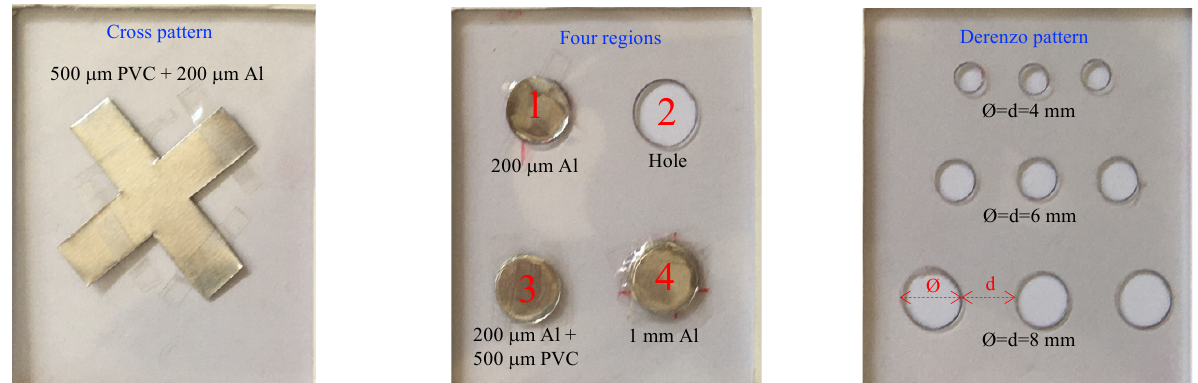
Fig. 4. Set of samples made with a 500- µ m PVC matrix layer containing different patterns that were analyzed at the CMAM facility using a 10-MeV-proton